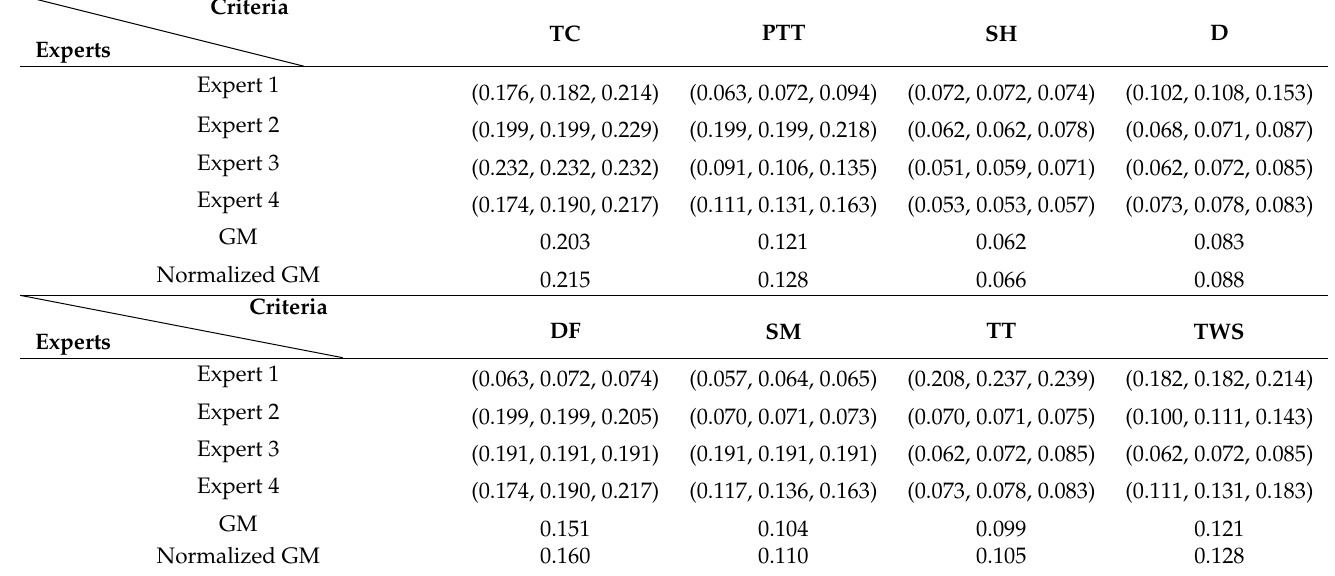
Table 4. The results of Fuzzy